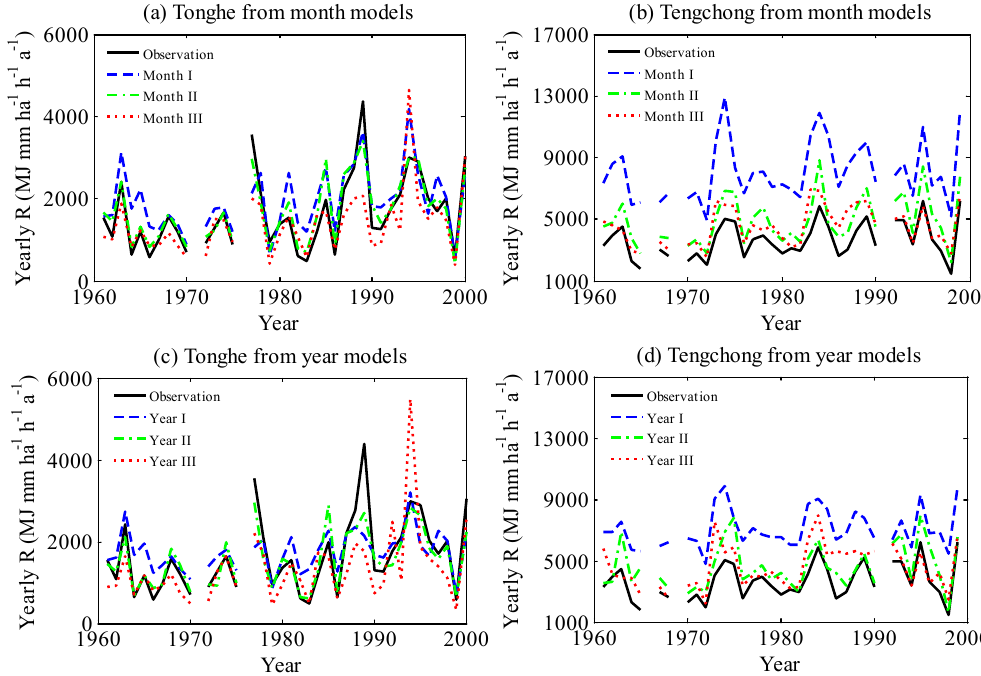
Figure 4. Comparison of yearly R values between observation values calculated using 1min resolution rainfall data and estimated values using month models (a, b) and year models (c, d) for the Tonghe and Tengchong stations. The years without marks were ineffective